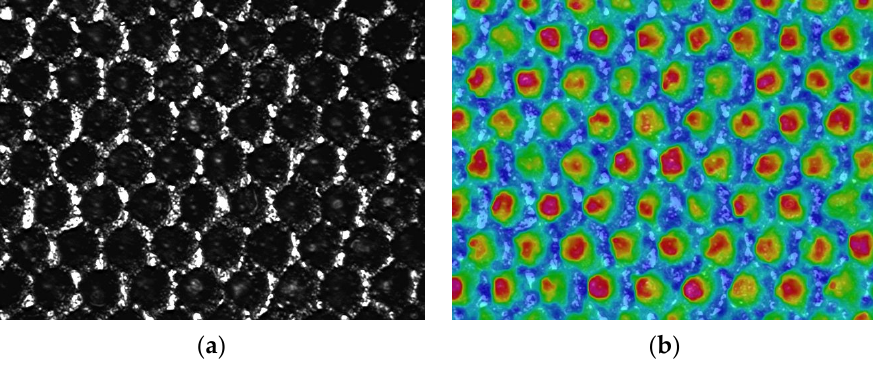
Figure 13. Photos of the surface of a long-used anilox roller at one measuring point: ( a ) surface view; ( b ) colour relief.